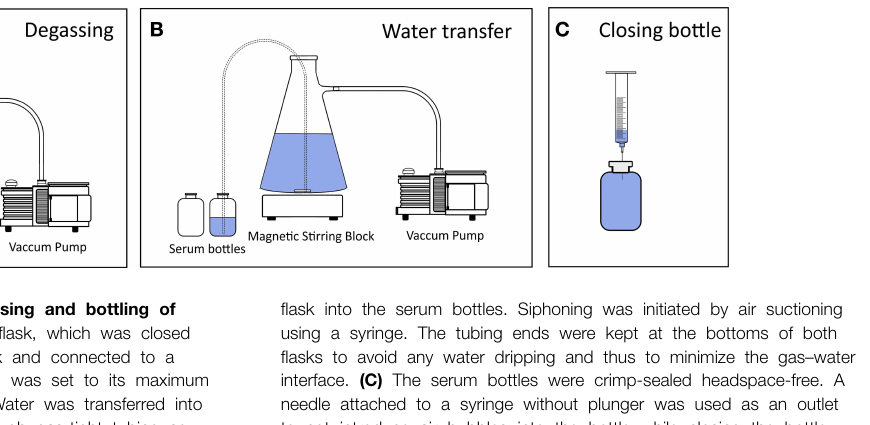
flask into the serum bottles. Siphoning was initiated by air suctioning using a syringe. The tubing ends were kept at the bottoms of both flasks to avoid any water dripping and thus to minimize the gas–water interface. (C) The serum bottles were crimp-sealed headspace-free. A needle attached to a syringe without plunger was used as an outlet to not introduce air bubbles into the bottle while closing the bottle with a rubber